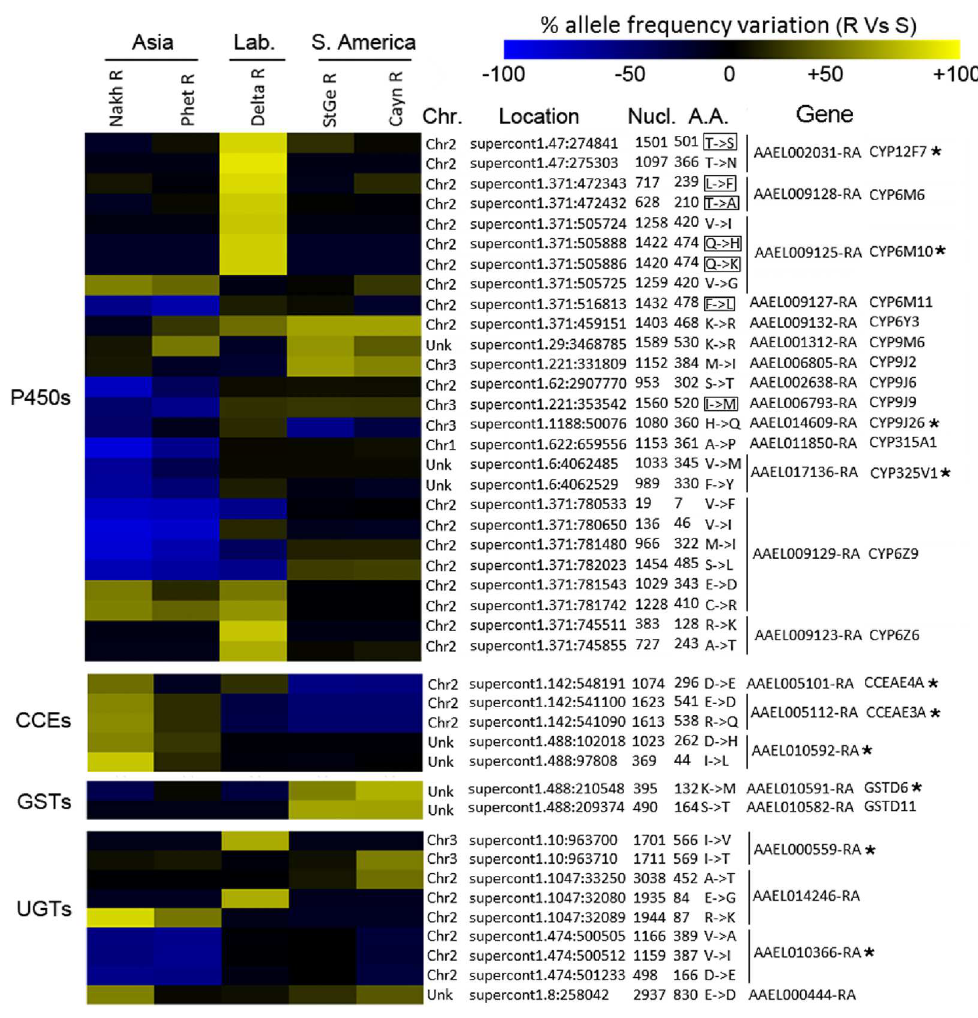
Fig 5. Non-synonymous differential SNPs affecting detoxification genes. Colorscaleshowsthe meanallele frequency variationbetweeneachresistantstrainandall susceptiblestrains. Yellow/blue colorsindicatean increase/ decreasefrequencyof the variantallelein the resistant populationrespectively.Chromosome, supercontig, base position, nucleotidevariation(ref > var), strand, positionin cDNA, positionin protein,amino-acidchange(ref > var), geneaccession andgenenameare indicated. Stars indicategenespreviouslyaffected by NS Diff SNPs as reported in [28].Boxedaminoacidchangesindicatevariations likelyaffectingsubstratebindingsite.